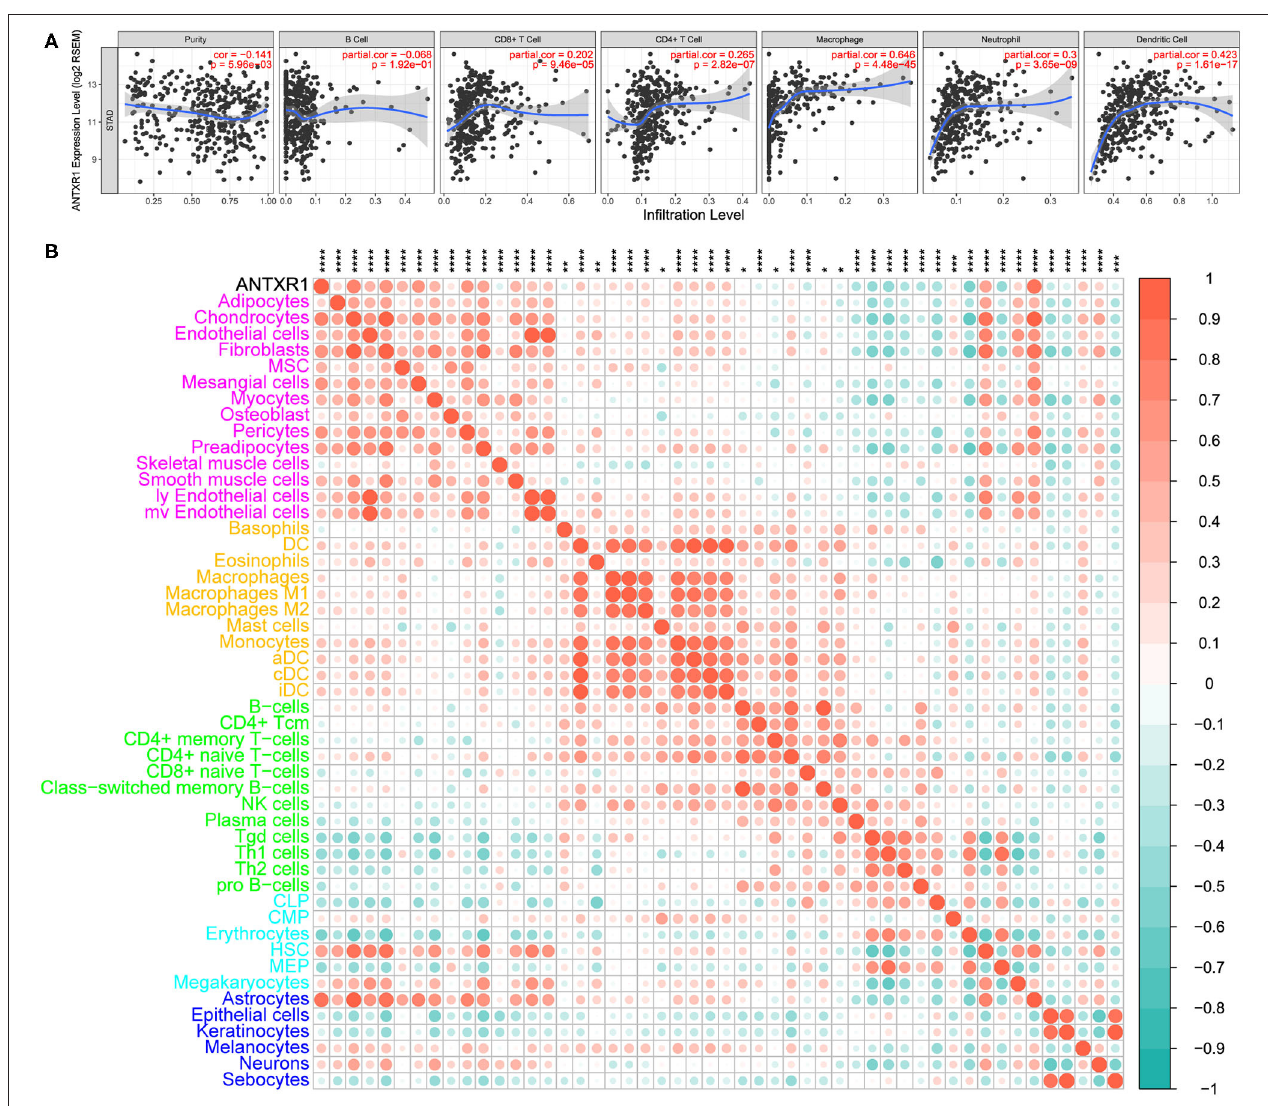
FIGURE 5 | Correlation between ANTXR1 expression and immune and stromal cell infiltration in gastric cancer. (A) Relationship between ANTXR1 expression and six immune cells conducted by TIMER. (B) . Corrplot of ANTXR1 expression and 49 cell types calculated by xCell in gastric cancer. * P < 0.05, ** P < 0.01, *** P < 0.001, **** P <